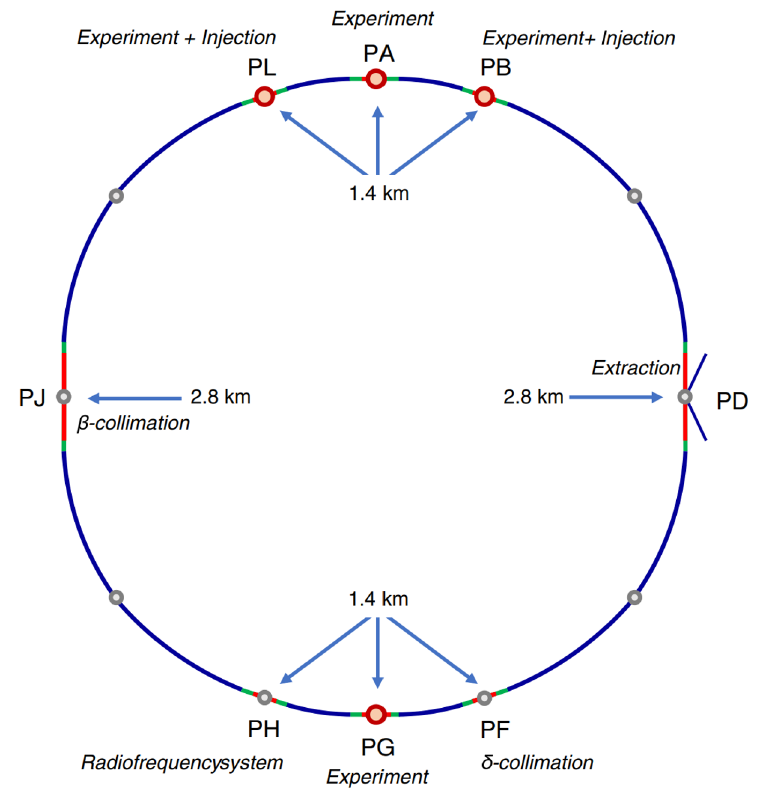
Figure 2 . The conceptual layout of FCC-hh. PB, PL denote the proton beams injection points combined with secondary experiments. PA, PG denote the main experiments. PD denotes the beam extraction point. The figure is taken from [34].